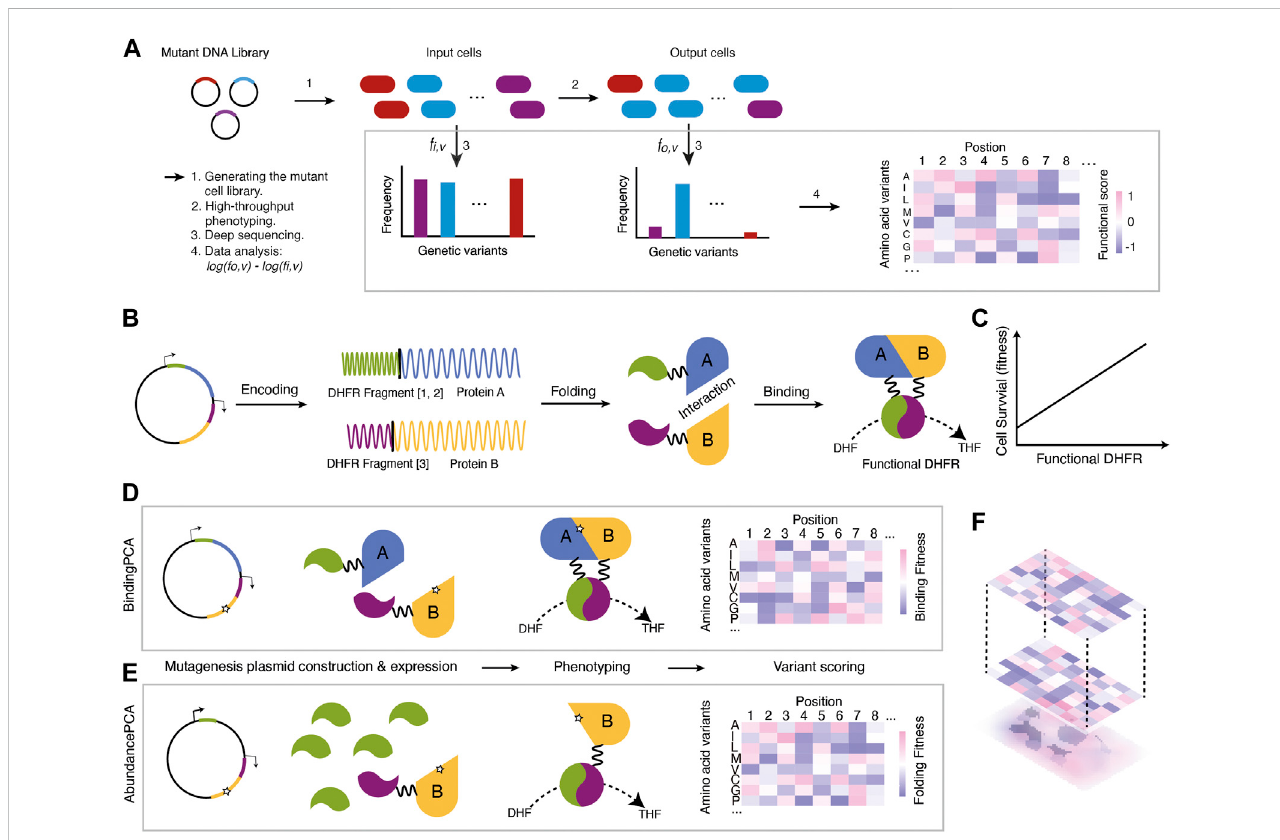
FIGURE 1 An overview of the DMS procedure (A) A mutant DNA library is transformed into cell types of interest to generate a mutant cell library. Then, the mutant celllibrarygoesthroughhigh-throughputphenotypingwherecellscarryingfunctionalvariantsareenriched(cells fi lledwithblue)whilethosewithdetrimental variants are depleted (cells fi lled with red or purple). Genetic variants are extracted and sequenced to calculate the relative enrichment changes before and afterselection.Finally,theenrichmentscoresareanalysedasthefunctionalscoresofmutations (B) Protein-FragmentComplementationAssay(PCA) (C) The underlying assumption is that the concentrations of functional DHFR are linearly related to cell survival ( fi tness) (D) BindingPCA captures mutational effects on both stability and protein-protein interactions without distinguishing them (E) AbundancePCA captures mutational effects on stability (F) ddPCA